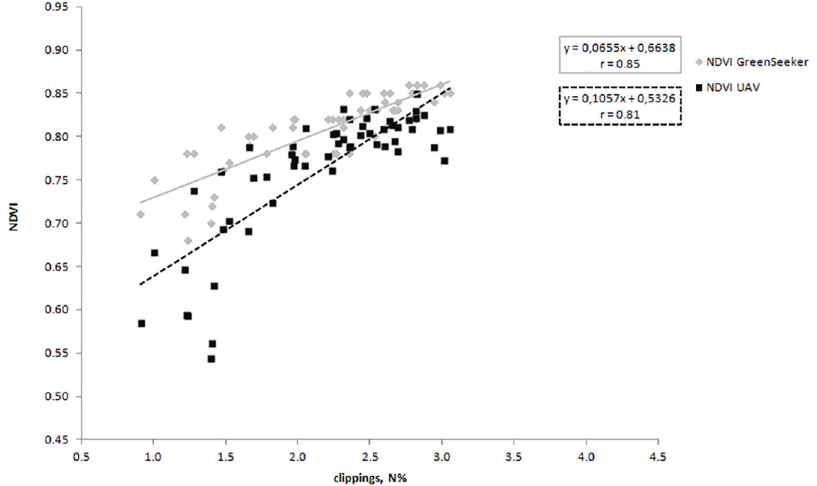
Fig 4. Relationships between the clippings nitrogen content of Zoysia matrella and NDVI data obtained with a ground-based spectral reflectance instrument (Trimble ’ s GreenSeeker sensor) and an unmanned aerial vehicle (UAV). Values represented the 4